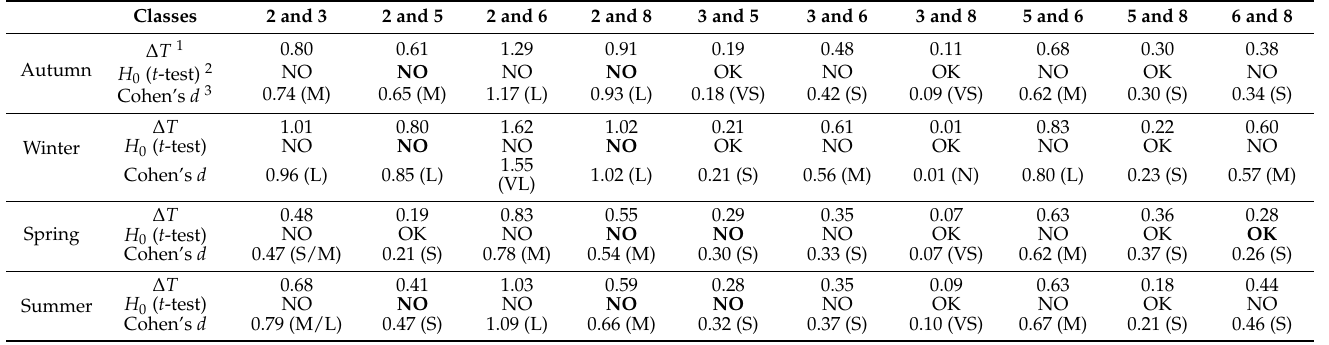
Table 9. Results of the t -tests and values of Cohen’s d for each pair of artificial classes in the four seasons (study period